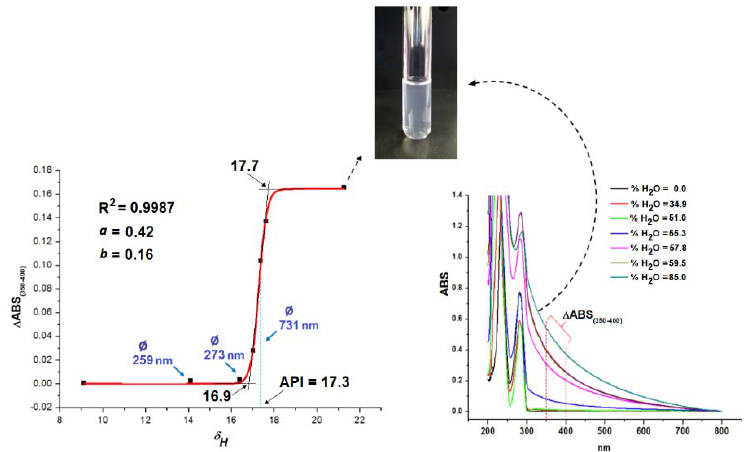
Figure 5. On the left , the sigmoidal aggregation profile of resorc[4]arene R1 as obtained in THF/water solvent system. Regression analysis to fit the experimental data was performed according to Equation (2). On the right , the UV − visible spectra of resorc[4]arene R1 (3.2 × 10 − 5 M) in different THF/water solvent systems.